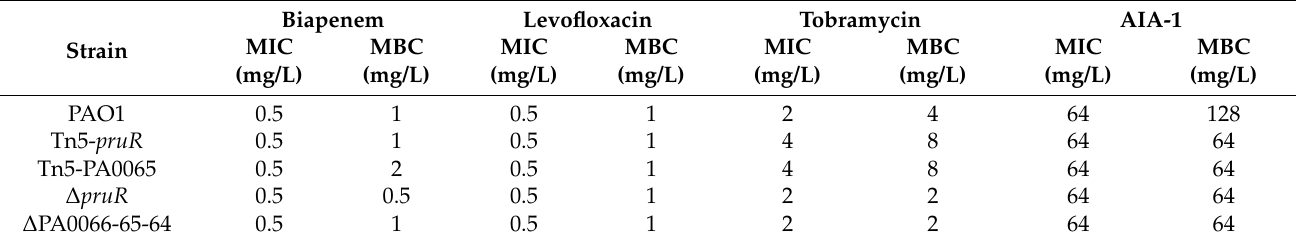
Table 1. Minimum inhibitory concentration (MIC) and minimum bactericidal concentration (MBC) of AIA-1 and various antibiotics to ∆ pruR and ∆